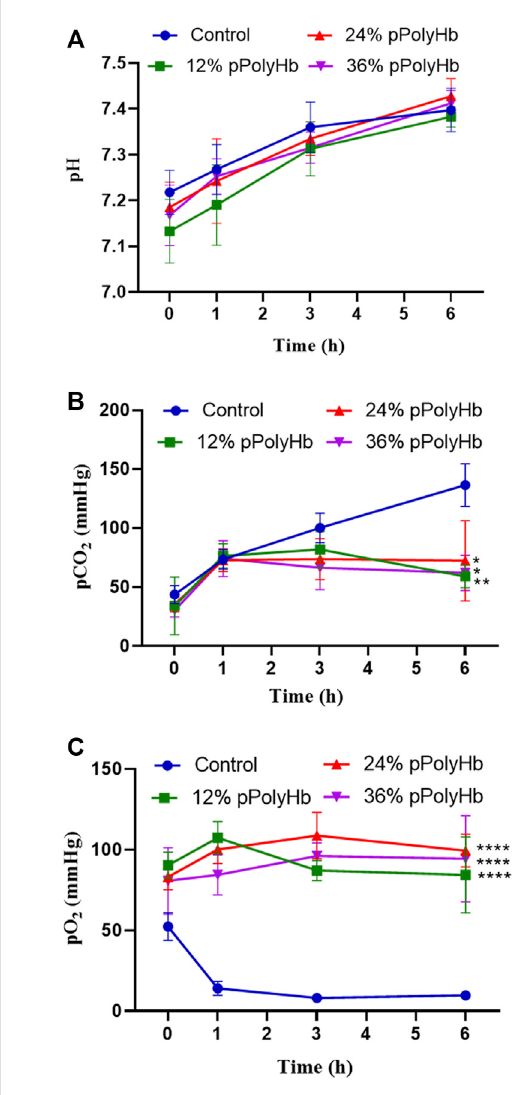
FIGURE 3 (A) There was no signi fi cant difference in pH between the four groups during perfusion (B) pCO2 in the three groups supplemented with pPolyHb was signi fi cantly lower than that in basal perfusate group (* p < 0.05, ** p < 0.005) (C) pO2 in the three groups supplemented with pPolyHb during perfusion was signi fi cantly higher than that in basal perfusate group (**** p < 0.0001) (Note: * stands for comparison with the control group). During the perfusion period, the change range of Na + was relatively stable, ranging from 147.67 ± 3.215 mmol/L to 182.75 ± 8.963 mmol/L, and the change range of K + was from 2.03 ± 0.208 mmol/L to 5.63 ± 0.306 mmol/L. The basal perfusate group of change, and the concentration increased with time. Ca 2+ decreased